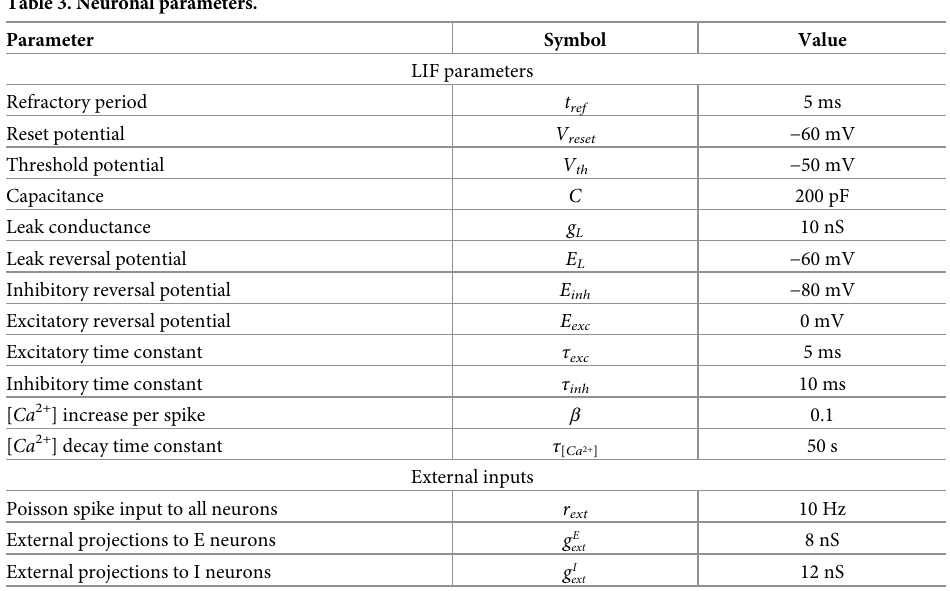
Table 3. Neuronal